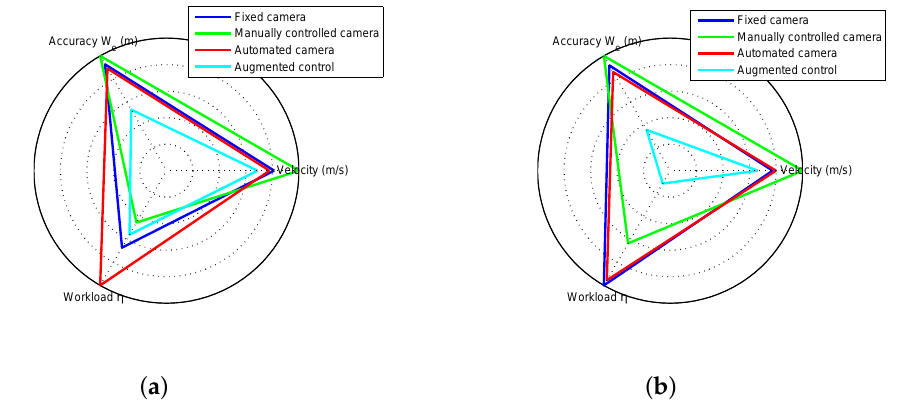
Figure 28. Comparison of speed, accuracy, and workload trade off for different teleoperation configurations. ( a ) Medium Speed; ( b ) Fast